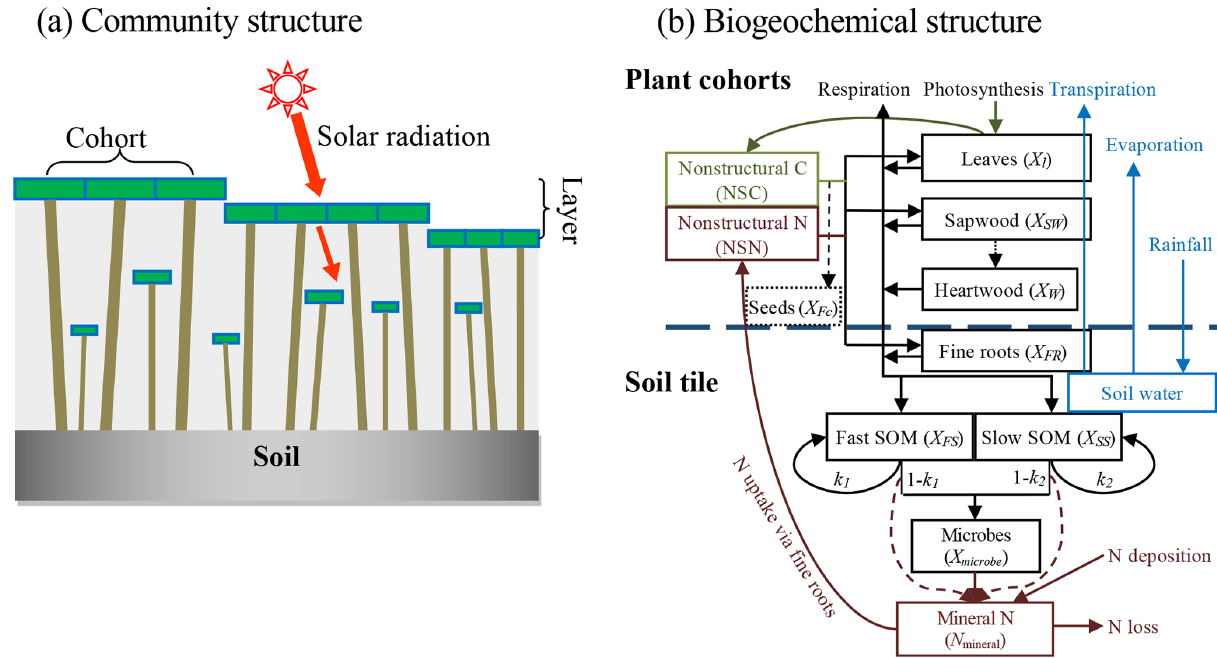
Figure 2. Structure of BiomeE. (a) Vegetation structure: trees organize their crowns into canopy layers according to both their height and their crown area following the rules of the PPA model, which mechanistically models light competition. (b) Biogeochemical structure and compartmental pools. The green, brown and black lines are the flows of carbon, nitrogen, and coupled carbon and nitrogen, respectively. The green box is for carbon only. The brown boxes are nitrogen pools. The black boxes are for both carbon and nitrogen pools, where X can be C (carbon) and N (nitrogen). The C : N ratios of leaves, fine roots, seeds and microbes are fixed. The C : N ratios of woody tissues, fast soil organic matter (SOM) and slow SOM are flexible. Only one tree’s C and N pools are shown in this figure. The blue box and arrows are for water storage in soil and fluxes of rainfall, evaporation and transpiration. The model can have multiple cohorts of trees, which share the same pool structure. The dashed line separates the aboveground and belowground